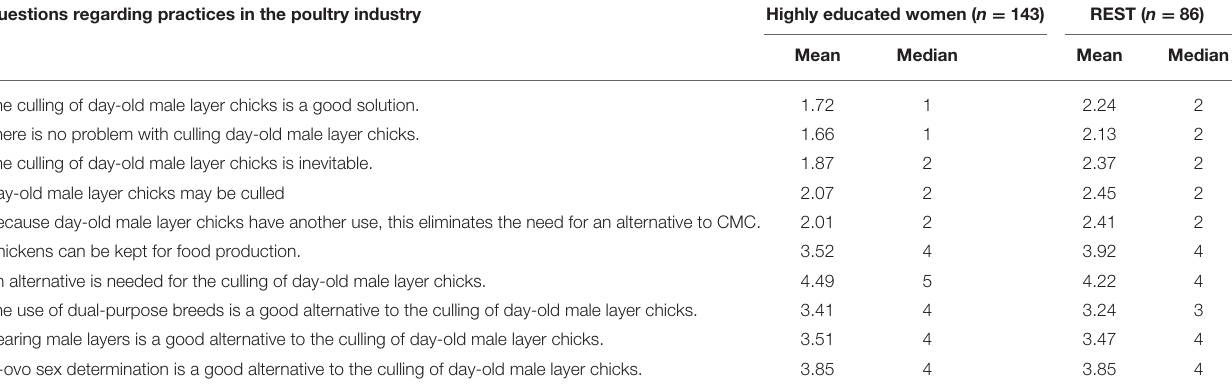
Table 3 | Mean and median outcomes for 10 agree/disagree questions rated on a Likert scale (1 = strongly disagree, 5 = strongly agree) regarding the acceptability of practices in the poultry